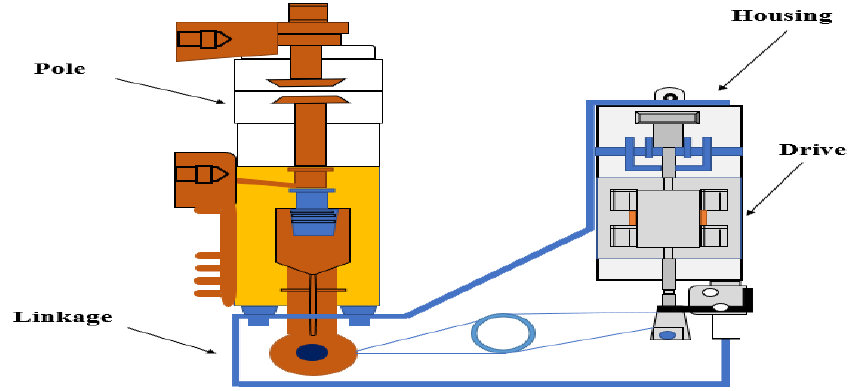
Figure 6. Circuit breaker for medium-voltage circuits.